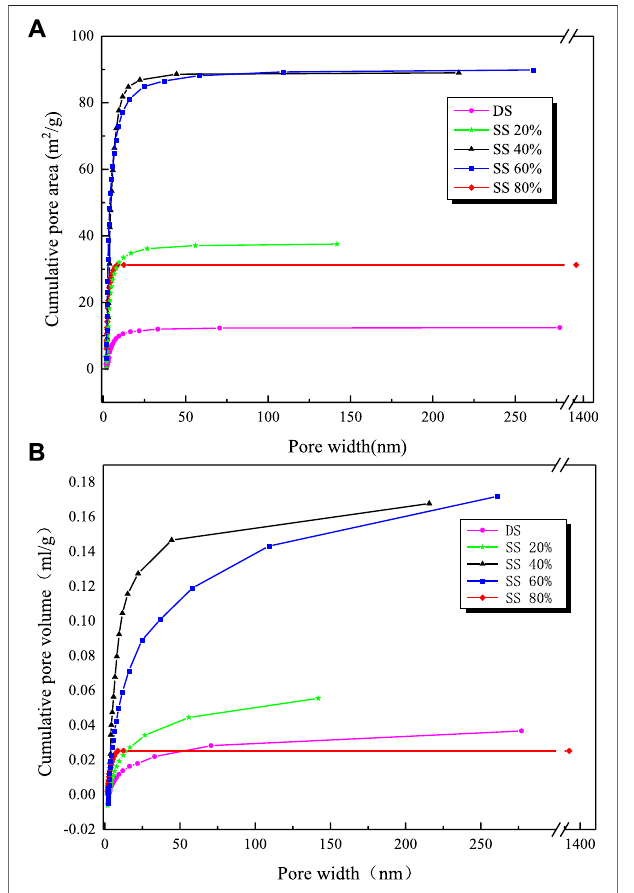
FIGURE 5 | Adsorption pore volume and pore area distribution curve of different mixing ratios of sludge and steel slag: (A) pore area and (B) pore volume.